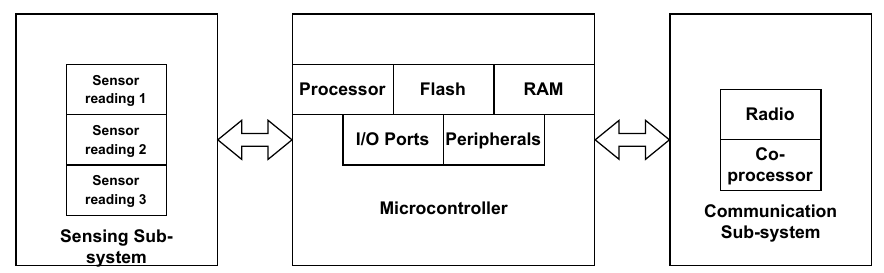
Figure 2. An overview example of a node’s hardware